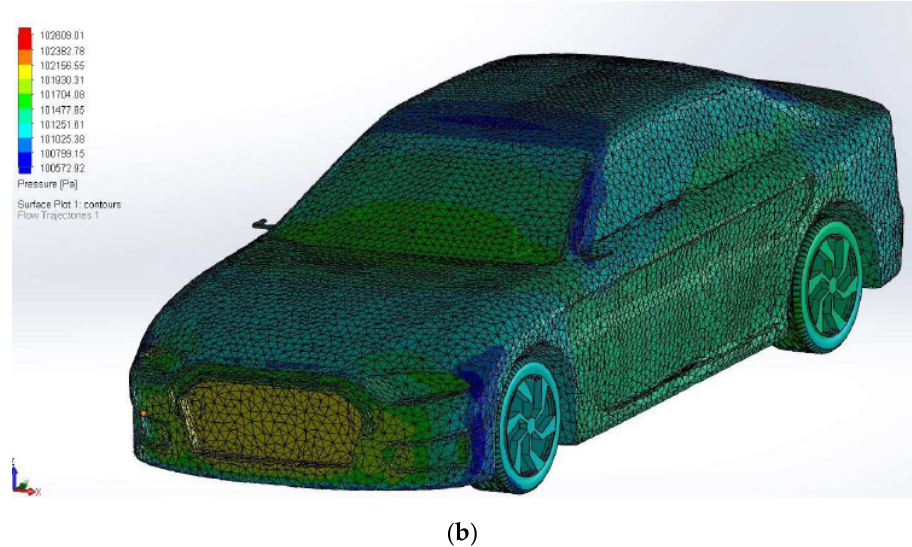
Figure 13. Flow simulation to define Cd for re-design phase: ( a ) Flow trajectory simulation; ( b ) surface plot rear side.